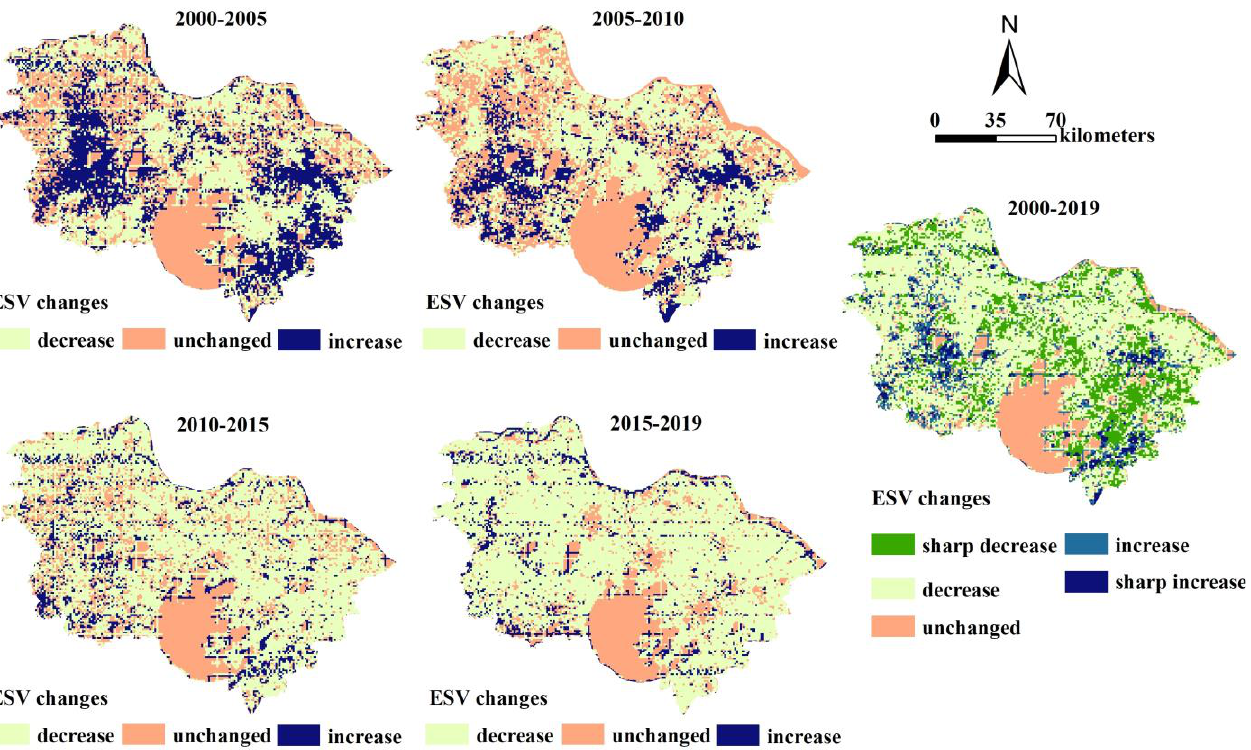
Figure 5. Spatial distribution of ESV changes in SCBJ from 2000 to 2019.